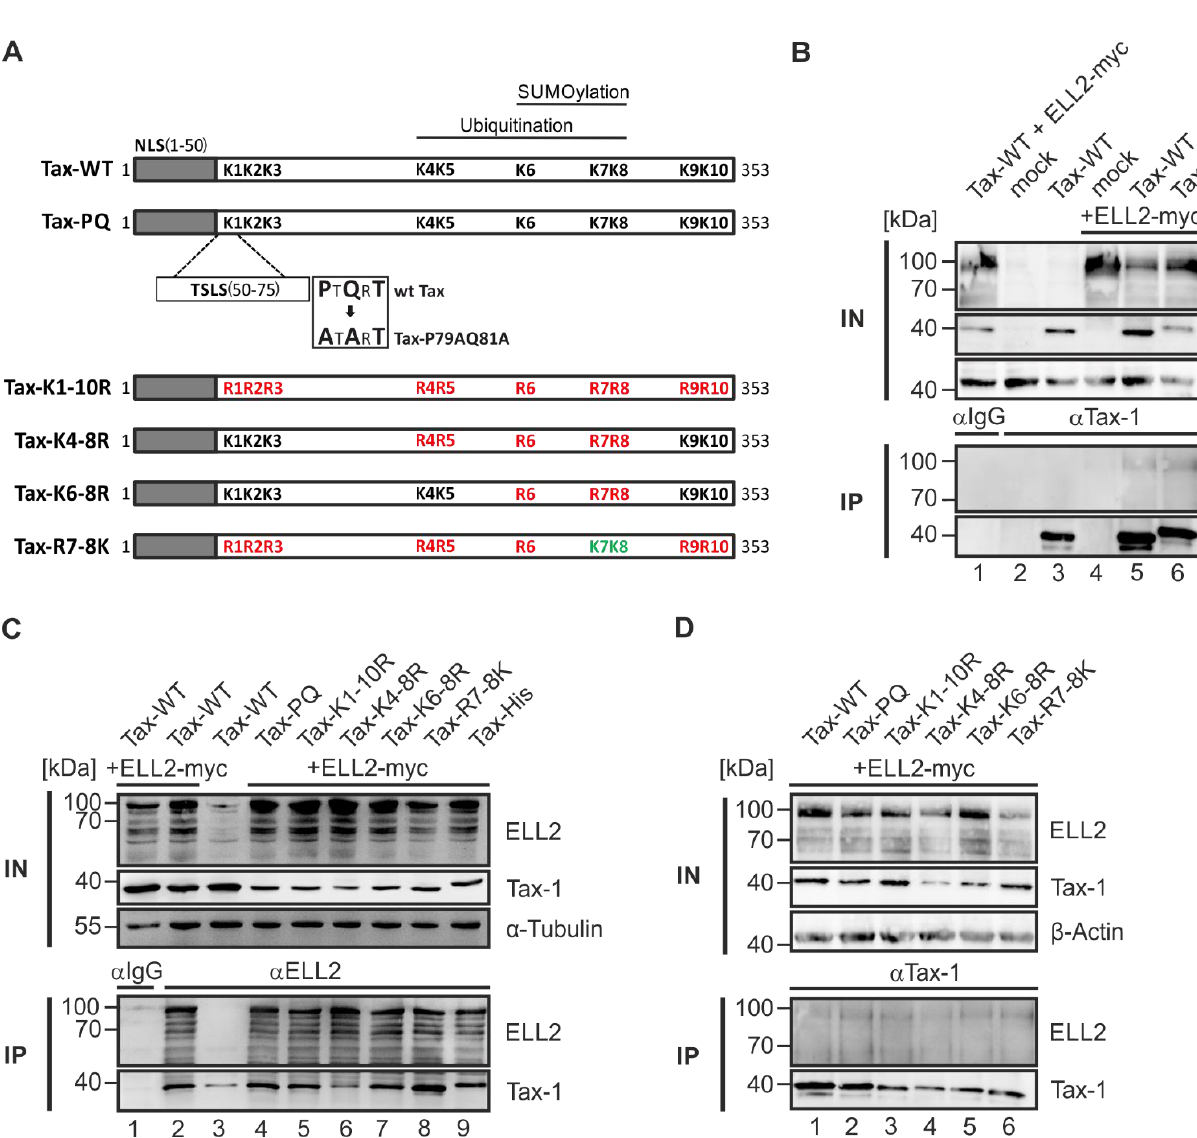
Figure 2. Tax-1 and ELL2 co-precipitate independent of established Tax-1 point mutations affecting Tax-1 post translational modifications. ( A ) Schematic overview of Tax-WT (wildtype) and Tax-1 point mutants. The N-terminal nuclear localization signal (NLS, amino acids (aa) 1–50), the Tax-1 speckled structure localization signal (TSLS, aa 50–75) and the potential TRAF-binding motif (PTQRT) and its substitution to an ATART motif in the construct Tax-PQ (Tax P79A Q81A) are indicated. Lysine (K) residues K1-K10 are depicted in black, mutations to arginines (R) in red, and mutations from R to K (based on K1-10R) in green. Lysine residues being critical for ubiquitination and SUMOylation are marked on top. ( B ) 293T cells were transfected with expression plasmids pSG-Tax-WT (Tax-WT), pEF-ELL2-myc (ELL2-myc), pSG-Tax-His (Tax-His; 1 µ g each) or the respective empty control vectors pSG5M and pEF (mock; 1 µ g each). Each sample was supplemented with the respective empty control vector to a total amount of 2 µ g of plasmid DNA if necessary. After 48 h, cells were lysed and 10% of the lysates were taken as input (IN) control. Co-immunoprecipitation (IP) was performed using anti-Tax antibodies or IgG control antibodies. One representative immunoblot out of five independent experiments is shown using antibodies targeting ELL2, Tax-1, β -Actin, and α -Tubulin. ( C , D ) 293T cells were transfected with expression plasmids pSG-Tax-WT, pSG-Tax-PQ (Tax-PQ), pSG-Tax-K1-10R (Tax-K1-10R), pSG-Tax-K4-8R (Tax-K4-8R), pSG-Tax-K6-8R (Tax-K6-8R), pSG-Tax-R7-8K (Tax-R7-8K), pSG-Tax-His (Tax-His), and pEF-ELL2-myc (ELL2-myc; 1 µ g each). IPs were performed using ( C ) anti-ELL2 or IgG control antibodies or ( D ) anti-Tax antibodies. One representative out of ( C ) four or ( D ) five independent experiments is